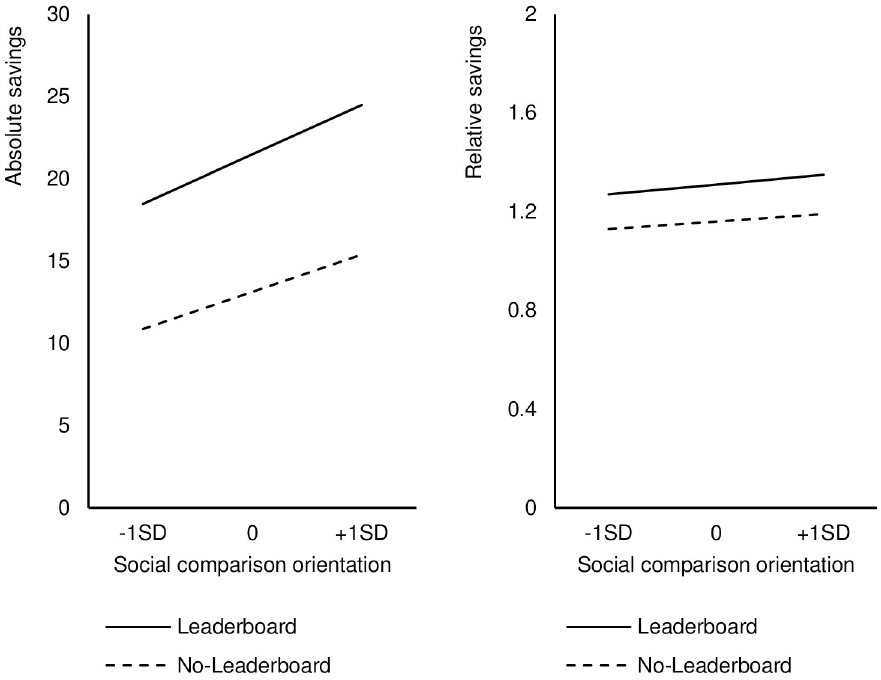
Fig 2. Absolute savings (left panel) and relative savings (right panel) as a function of the leaderboard and the social comparison orientation. (Error bars indicate +/–1 Standard Error of the Mean).